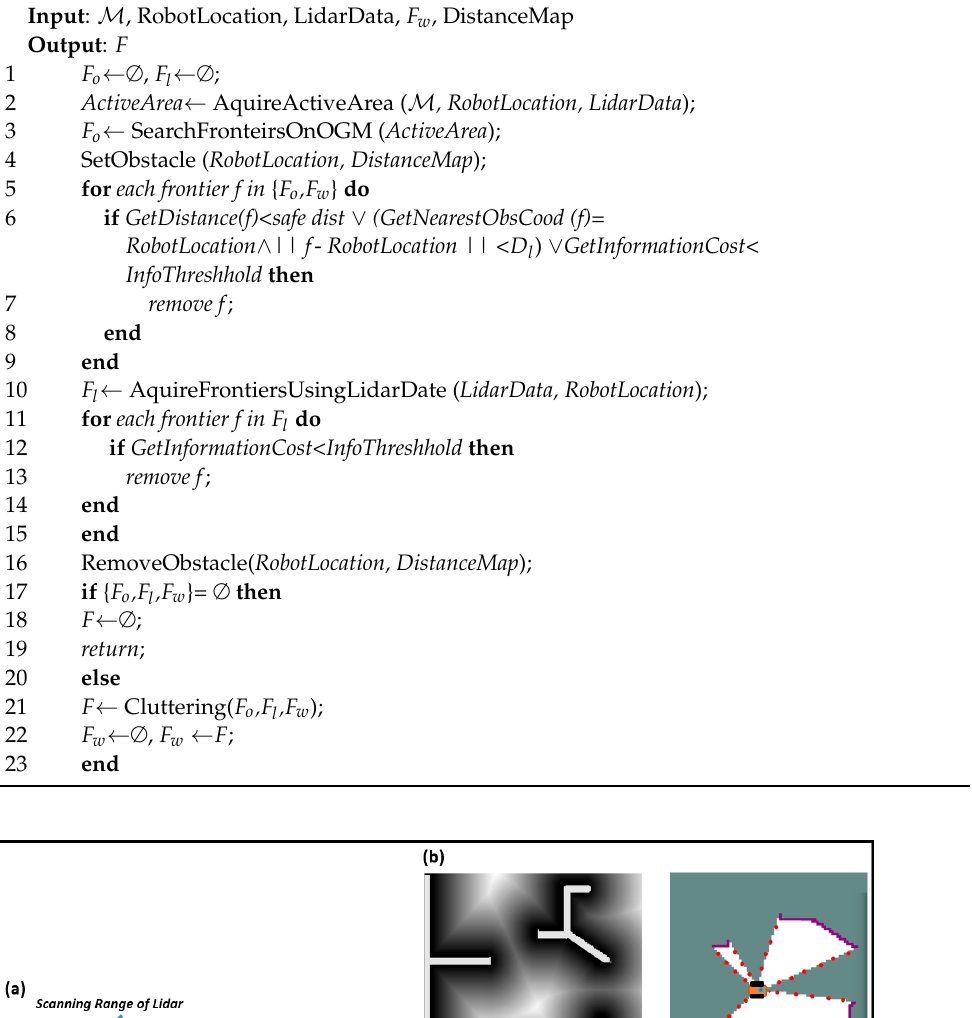
Algorithm 2. Frontier Detection and Maintenance.